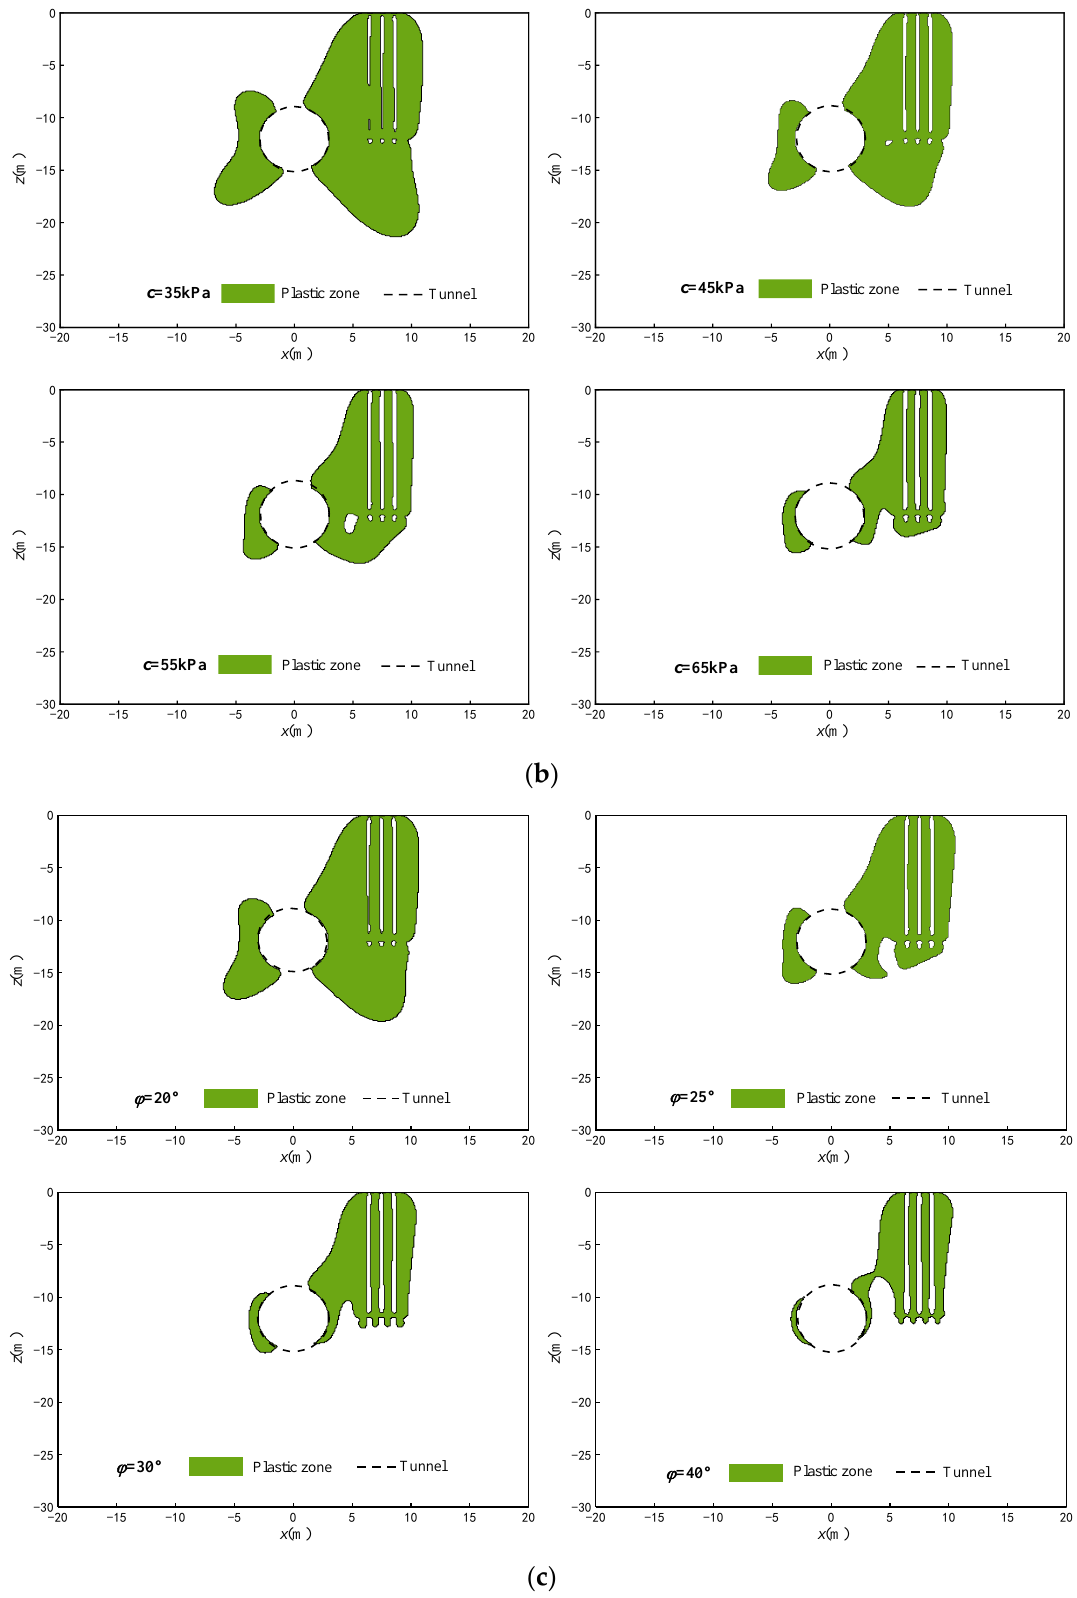
Figure 11. Potential plastic zones for different soil parameters when d 1 = 6 m, d 2 = 7 m, d 3 = 8 m, d 4 = 9 m ( x coordinate of each pile) and h = 12 m. ( a ) Different magnitudes of volumetric weight; ( b ) Different magnitudes of cohesion; ( c ) Different magnitudes of the angle of internal friction.